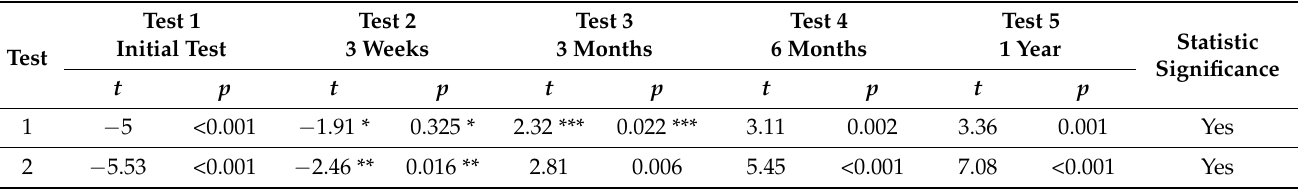
Table 2 for initial moment, 3 weeks, 3 months, 6 months and 1 year. Table 2. Student’s t -test test for group A and B, for each testing.